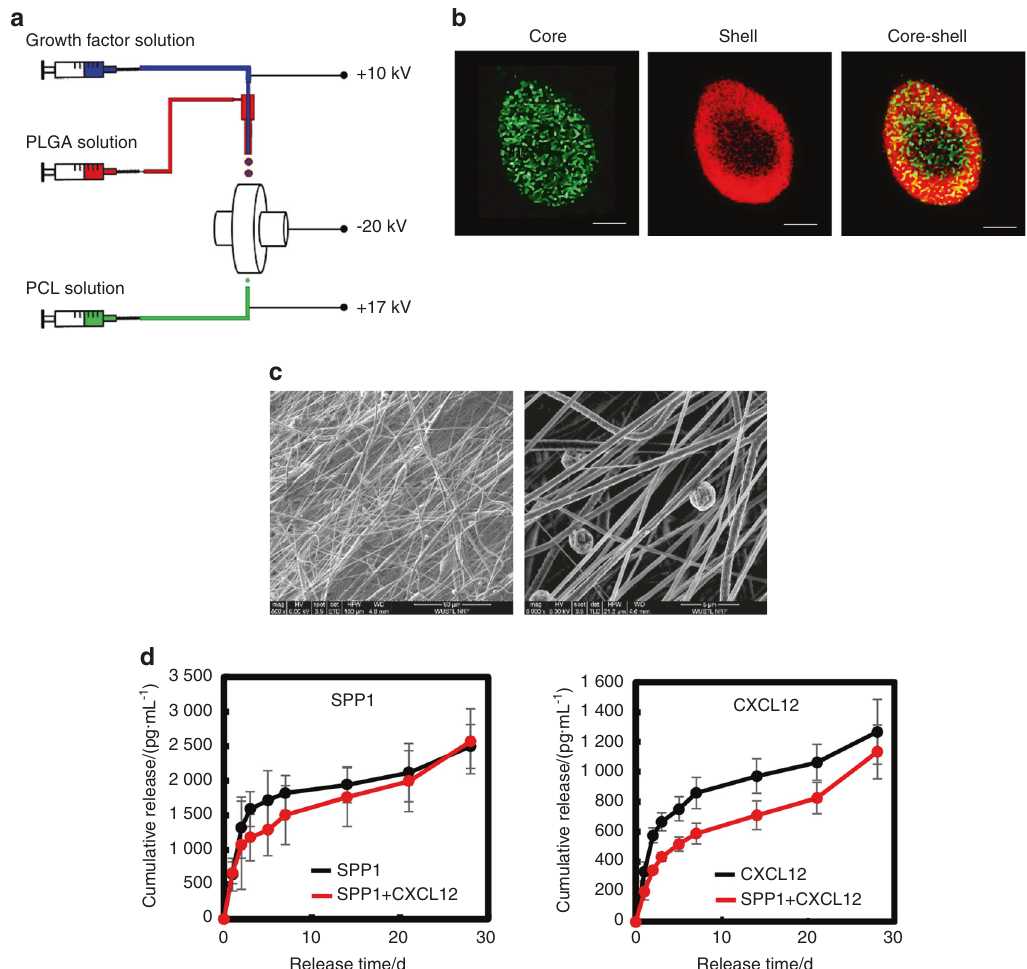
Fig. 4 PCL scaffolds gradually released SPP1 and CXCL12 in vitro. a Schematic illustration of the simultaneous electrospinning and electrospraying system for PCL scaffold fabrication. b Representative confocal images of the PLGA microspheres encapsulated with growth factors. PLGA: red; growth factor: green. c Representative SEM images of the PCL scaffold. d Pro fi les of SPP1 and CXCL12 release from PCL scaffolds loaded with SPP1 and CXCL12 ( n = 5). Scale bar, 200 μ